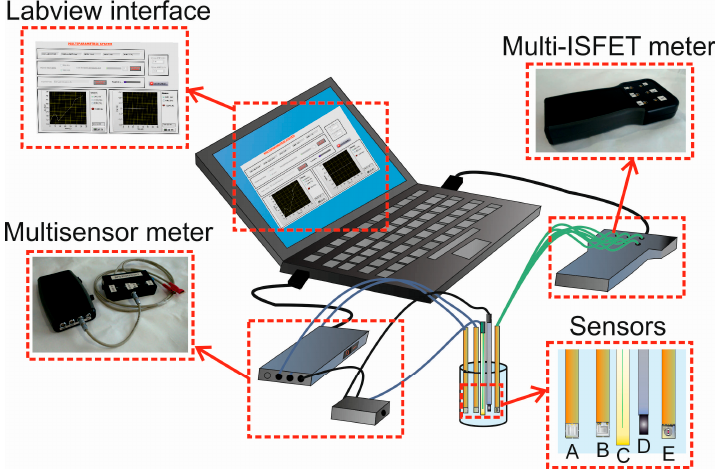
Figure 1. Scheme of the whole measurement system. In detail: ( A ) conductivity or ORP sensor; ( B ) amperometric sensor; ( C ) reference electrode; ( D ) counter electrode; and ( E ) ISFET.